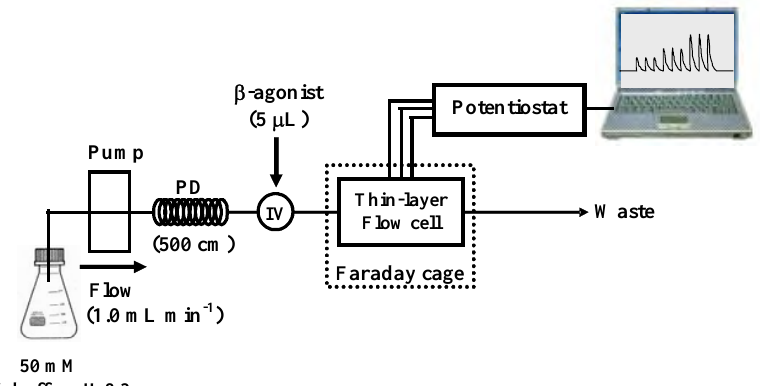
Figure 2. The flow injection manifold used in all amperometric measurements, including pulsed amperometry. PD: pulse dampener. IV: injection valve. The condition depicted is optimal configuration with Ag/AgCl and Pt as the reference and the auxiliary electrodes,